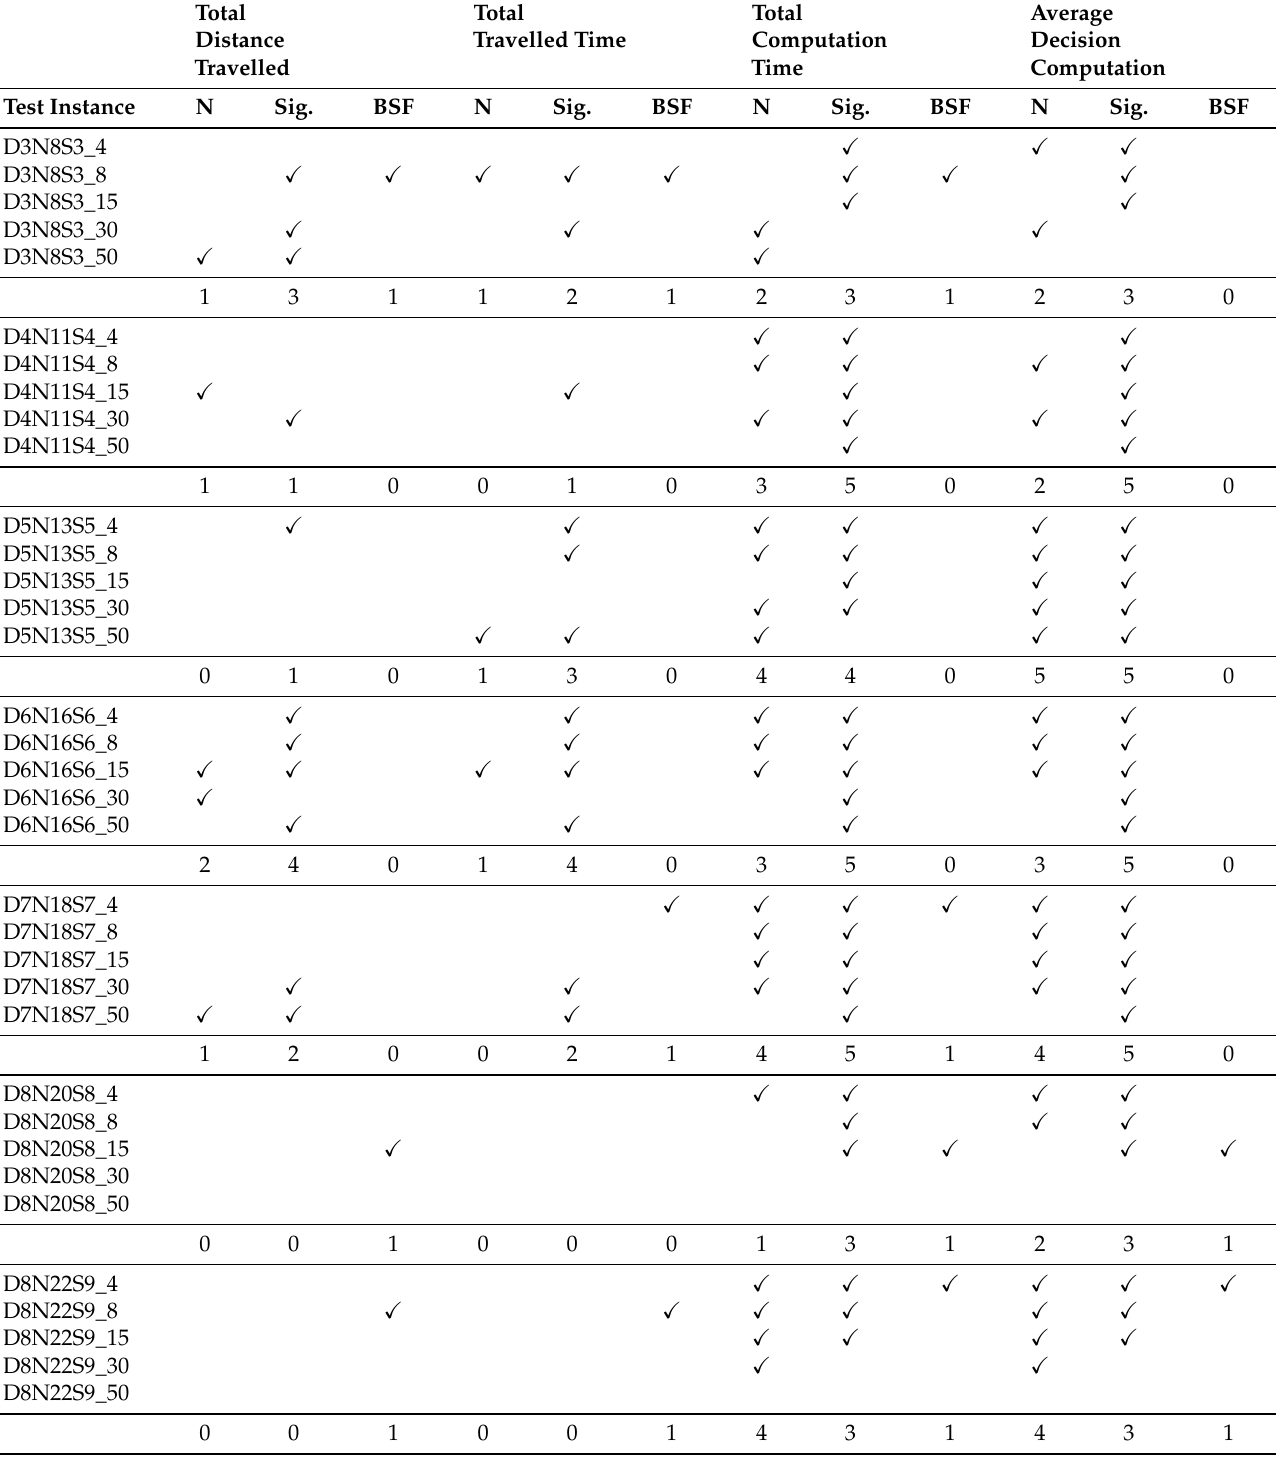
Total Travelled Time